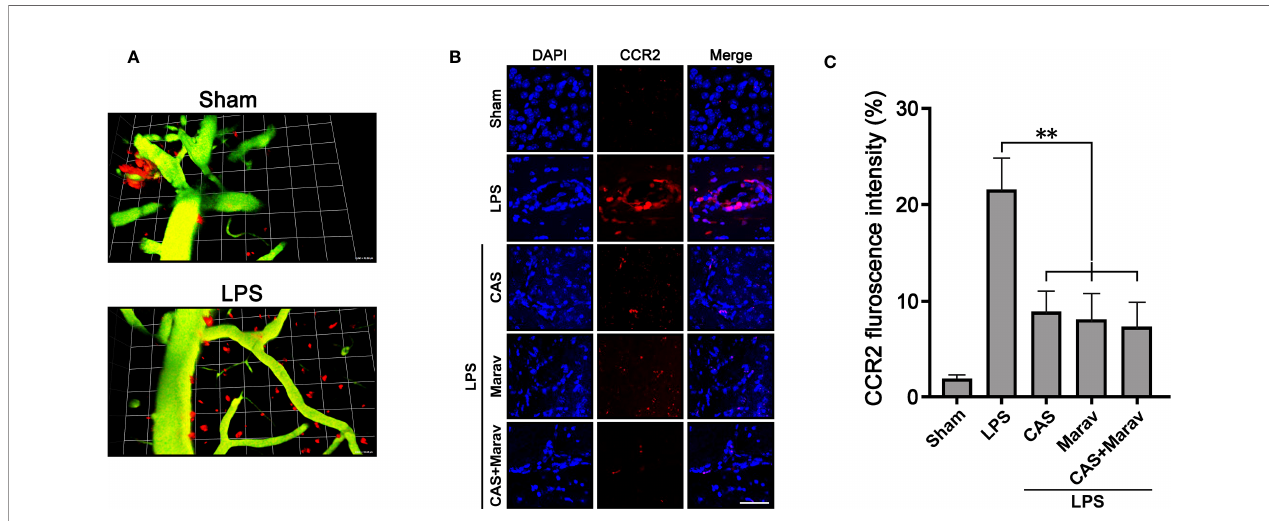
FIGURE 4 | Animal model of in fl ammation showing migration of CCR2::RFP cells into brain parenchymal tissue. (A) Intravital imaging con fi rms that CCR2::RFP cells emerge from a brain vessel in the LPS treatment group. (B) CCR2::RFP cells are increased in brain tissue injected with LPS. The in fl amed brain tissue treated with CAS, Marav, and CAS+Marav have decreased CCR2::RFP cells. (C) Graphs showing that the number of CCR2::RFP positive cells are decreased in the CAS, Marav, and CAS+Marav groups (sham intravital imaging group, n=1; LPS intravital and immunohistology imaging group, n=3; **P<0.05, scale bar=25 µm).